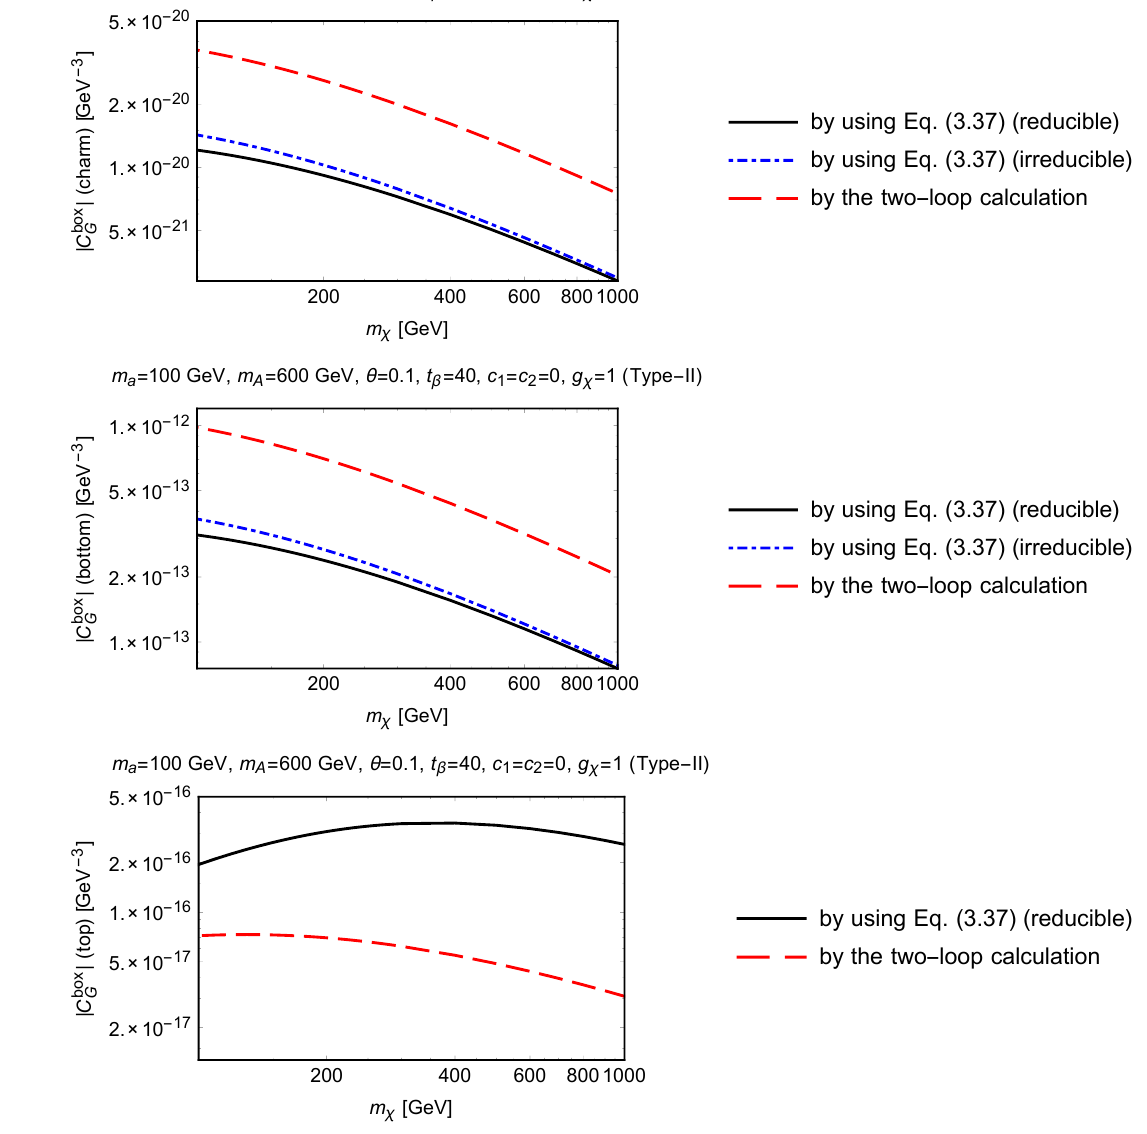
Figure 7 . The contributions from each of the box diagrams to C box 100 GeV, m A = 600 GeV, (cid:18) = 0 : 1, t (cid:12) = 40, c 1 = c 2 = 0, and g (cid:31) = 1. The THDM-type is the type-II. The upper, central, and bottom panels show the contributions from the charm, bottom, and top quarks, respectively. The black solid lines show the contributions which are derived from C box ( Q = c; b; t ) without irreducible decomposition by using the relation in eq. (3.16). The blue Q dotted lines are the same but with the irreducible decomposition. The red dashed lines show the contributions which are derived from the two-loop